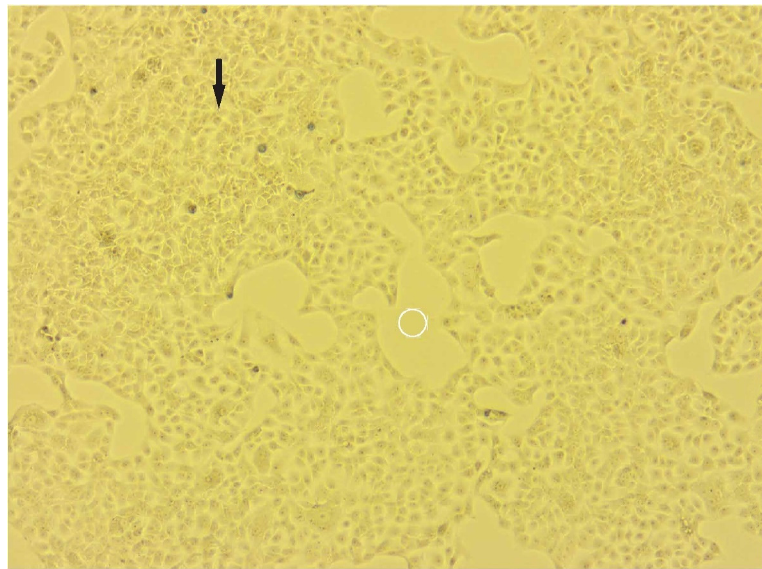
Figure 3. Photograph of a healthy Vero E6 culture, magnification 50×. Uninfected Vero E6 cells have a typical epithelial cell morphology and have translucent cytoplasm. Normally, there are dead cells in a small amount. Dead cells are small, round, and have dark cytoplasm. In Figure 3, the black arrow points to the confluent monolayer. The white circle shows the area not occupied by cells because the cells did not have enough time to propagate.